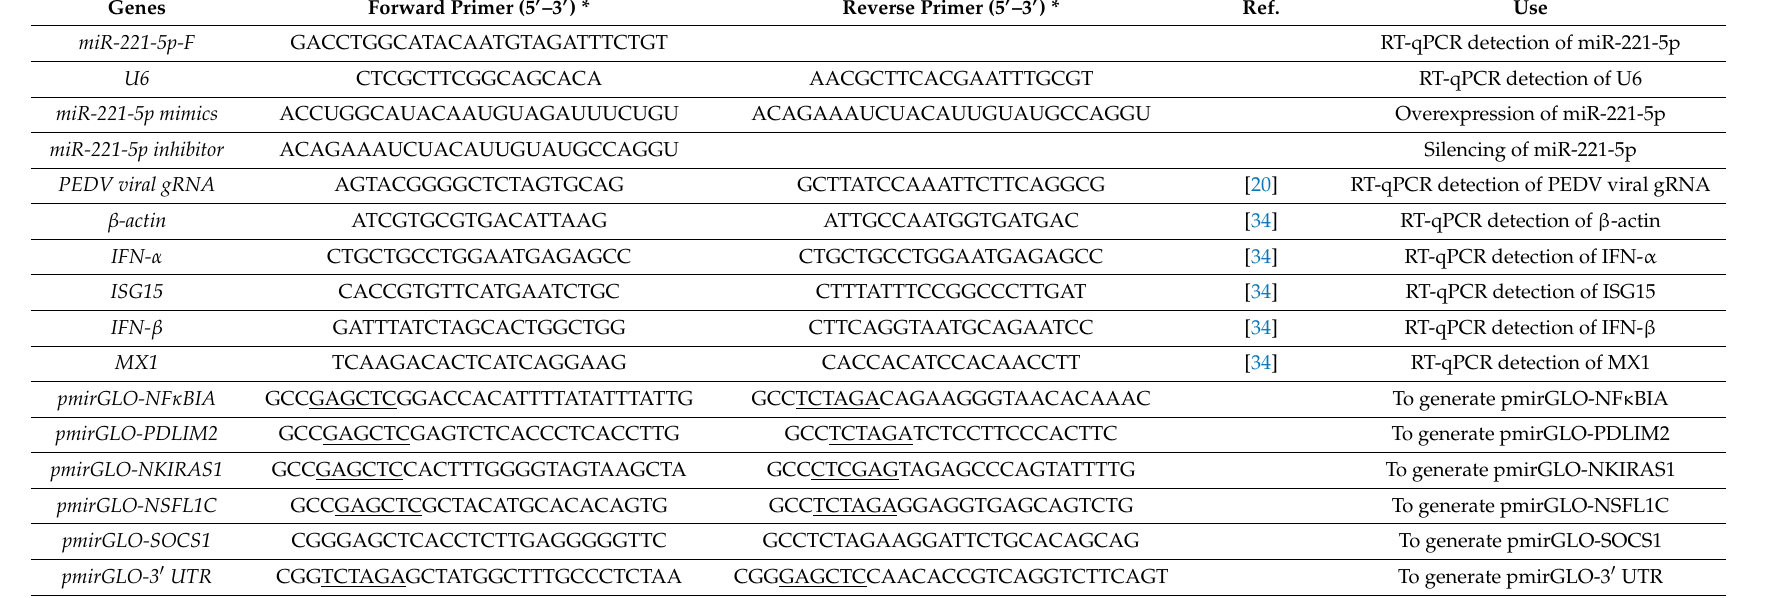
Table 2. Sequences of primer pairs used for qRT-PCR and plasmid